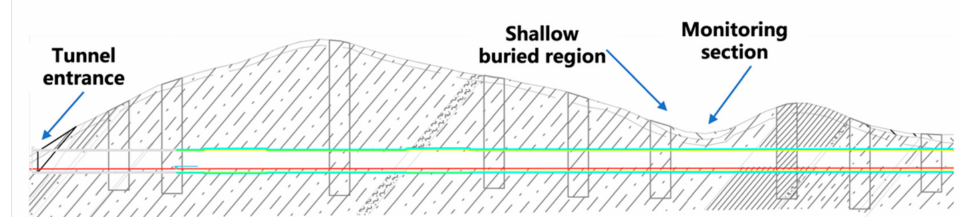
Figure 8. The geological layout of the Tongluoshan mountain at the shallowly buried tunnel